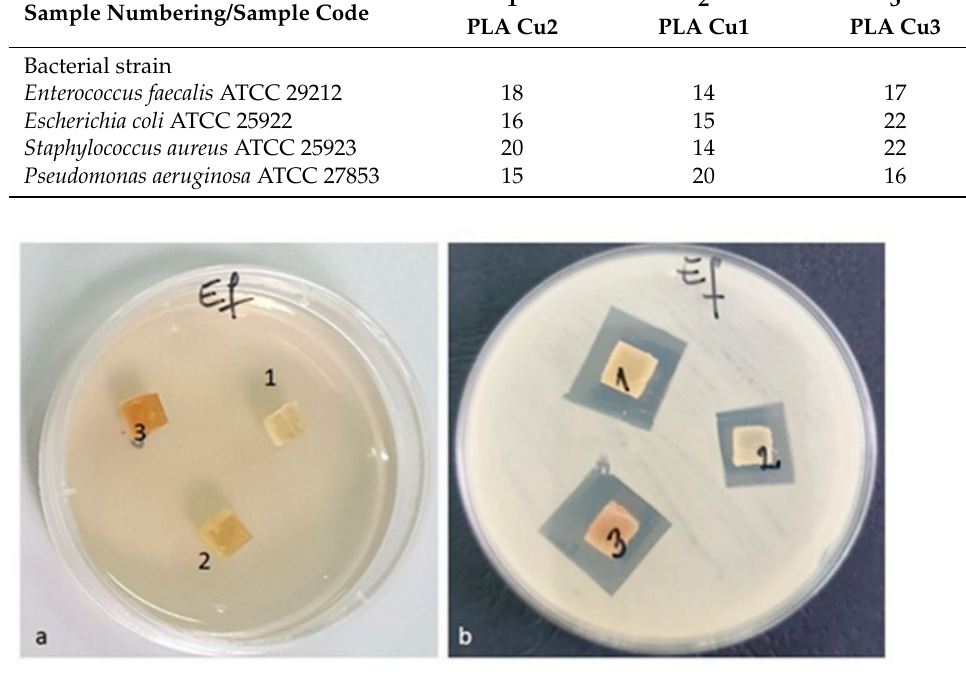
Figure 14. Enterococcus faecalis ATCC 29212 ( a ) zero (initial) moment, ( b ) inhibition after 48 h of incubation.